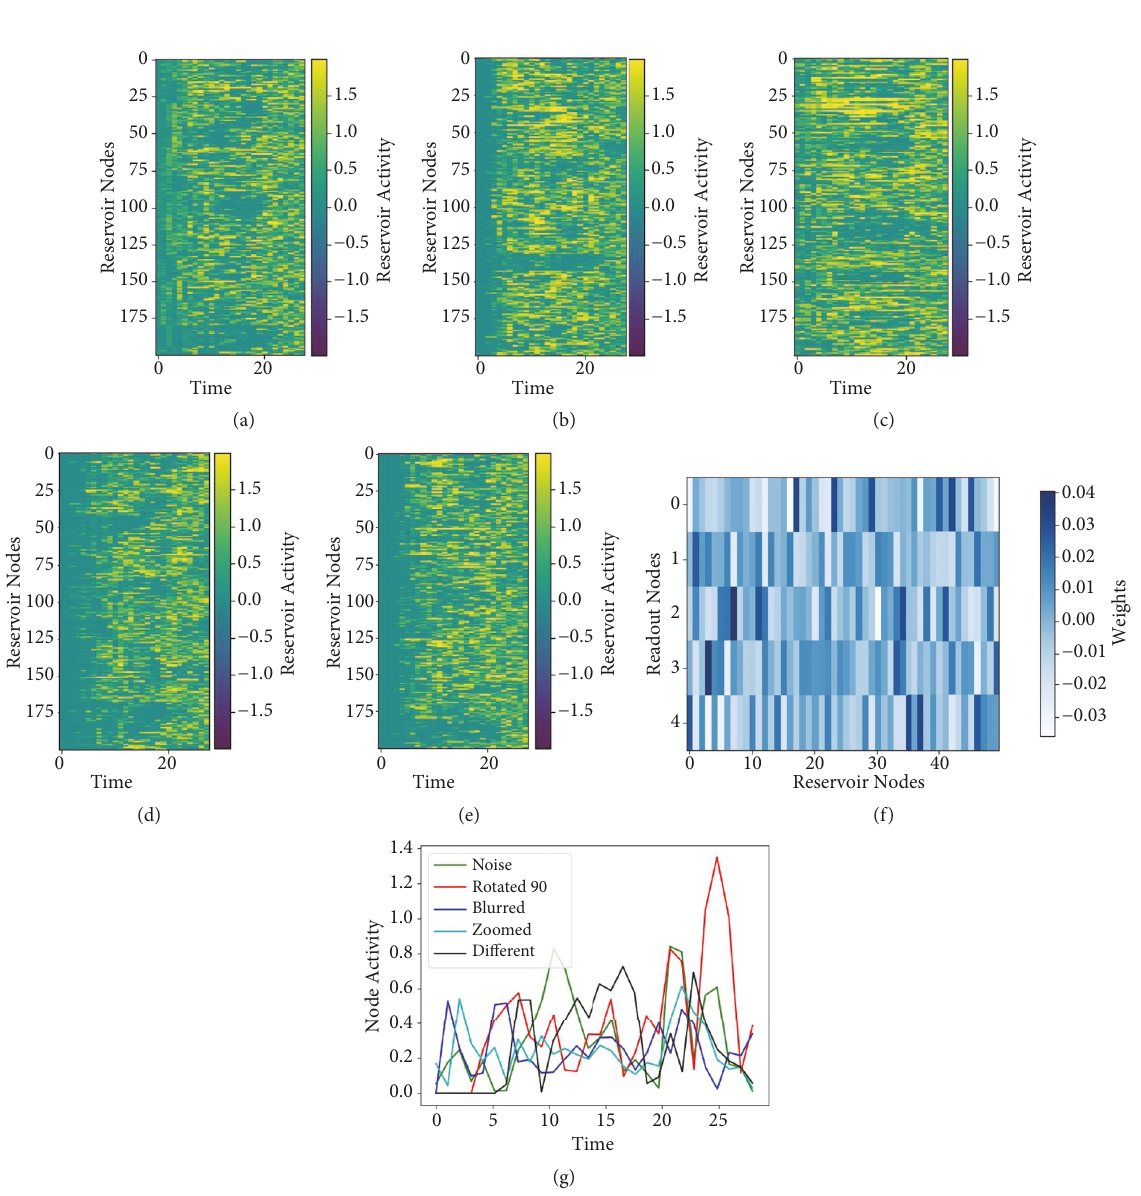
generalization than nonrecurrent architectures, they require much larger training data and more computational